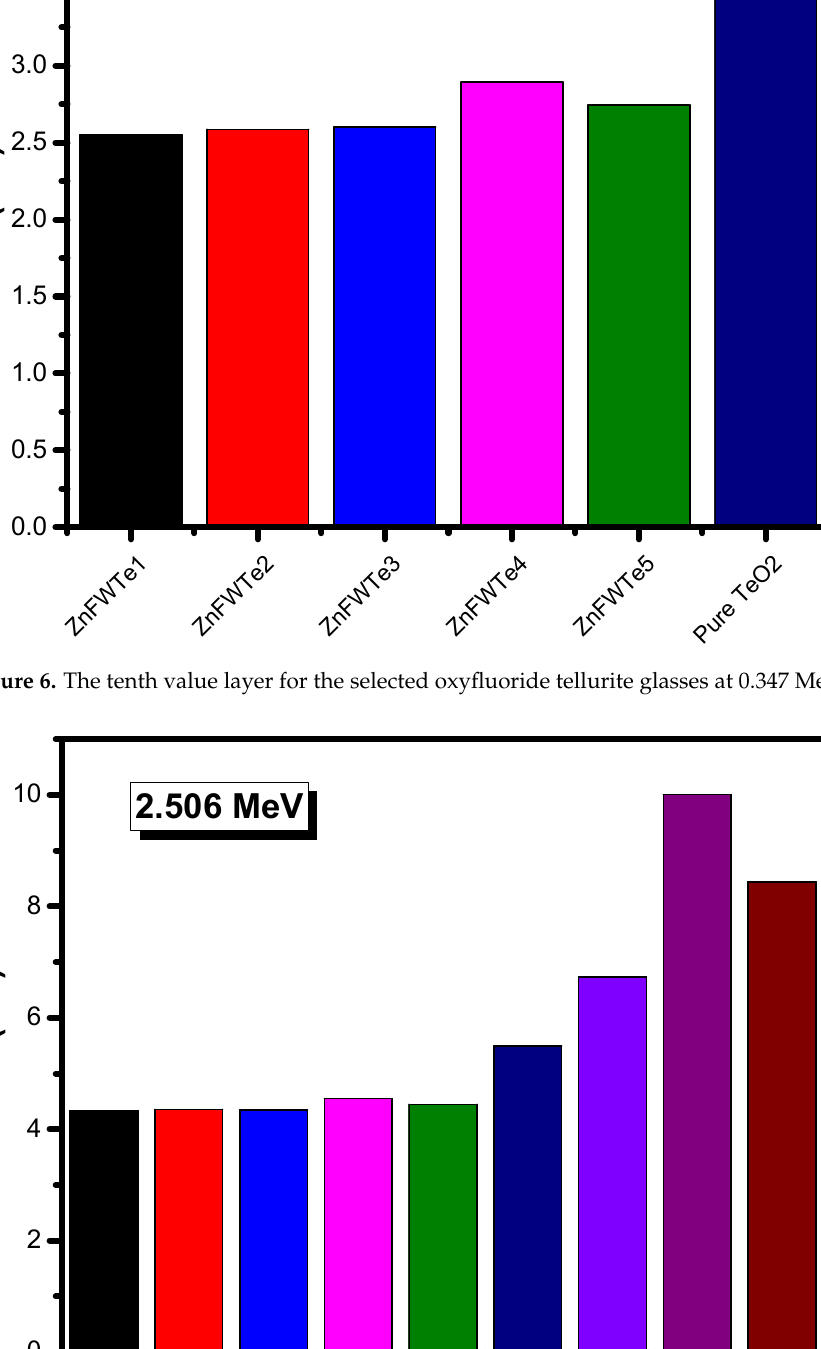
Figure 7. The mean free path for the selected oxyfluoride tellurite glasses at 2.506 MeV in comparison with other shielding materials.